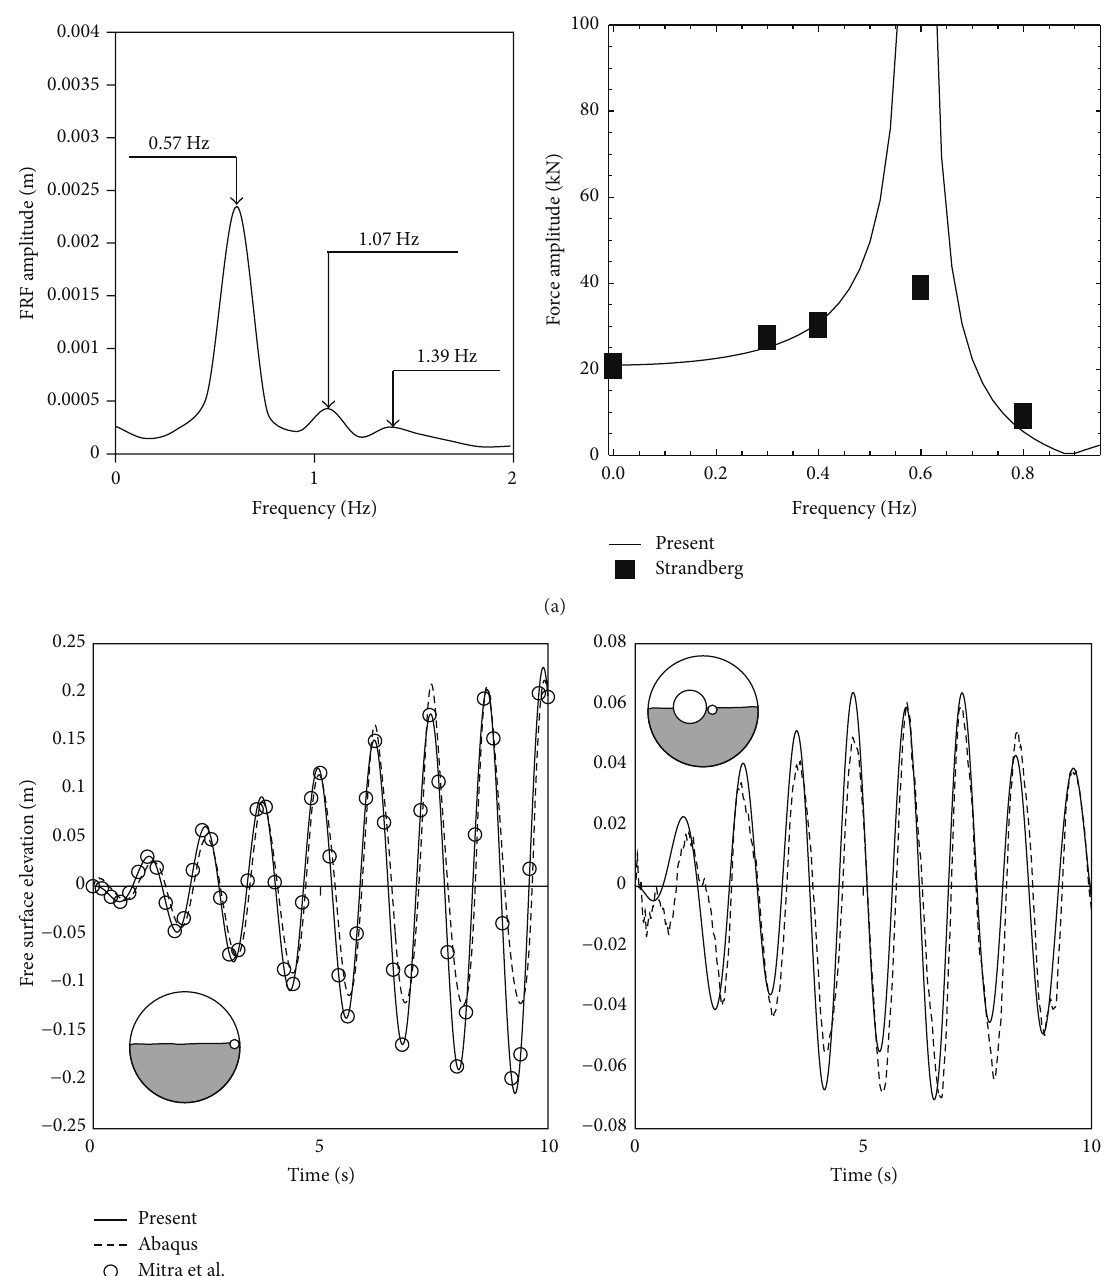
Figure 3: (a) Verification with results offered by Strandberg [25], (b) validated results with Abaqus.